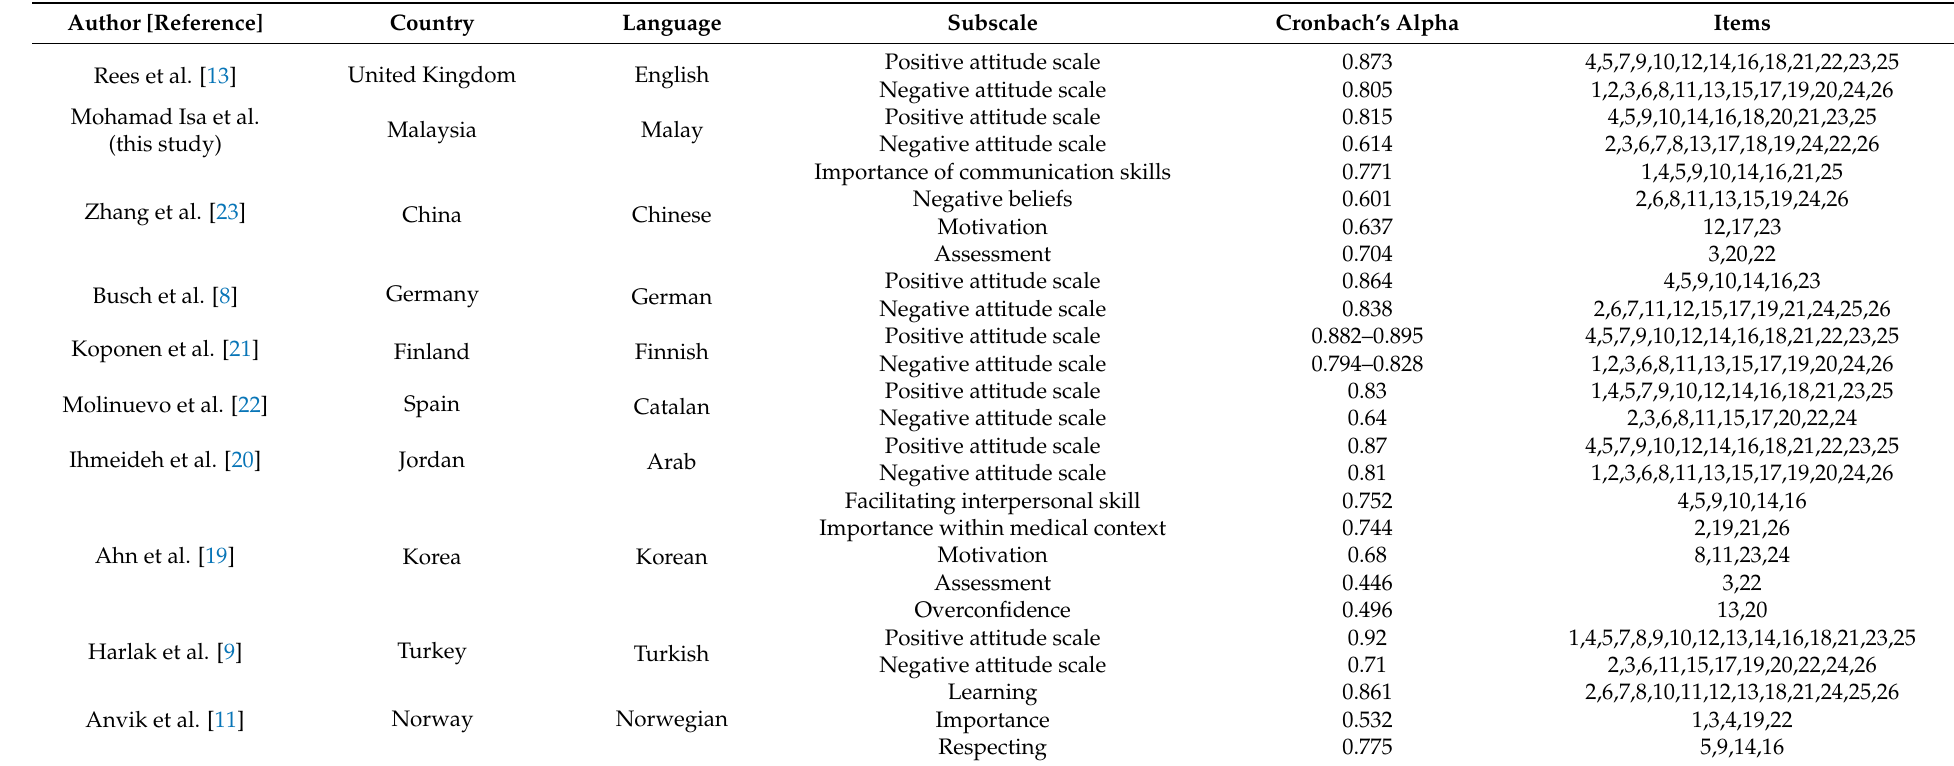
Table 4. Subscales and internal consistency values in translated versions of the Communication Skills Attitude Scale